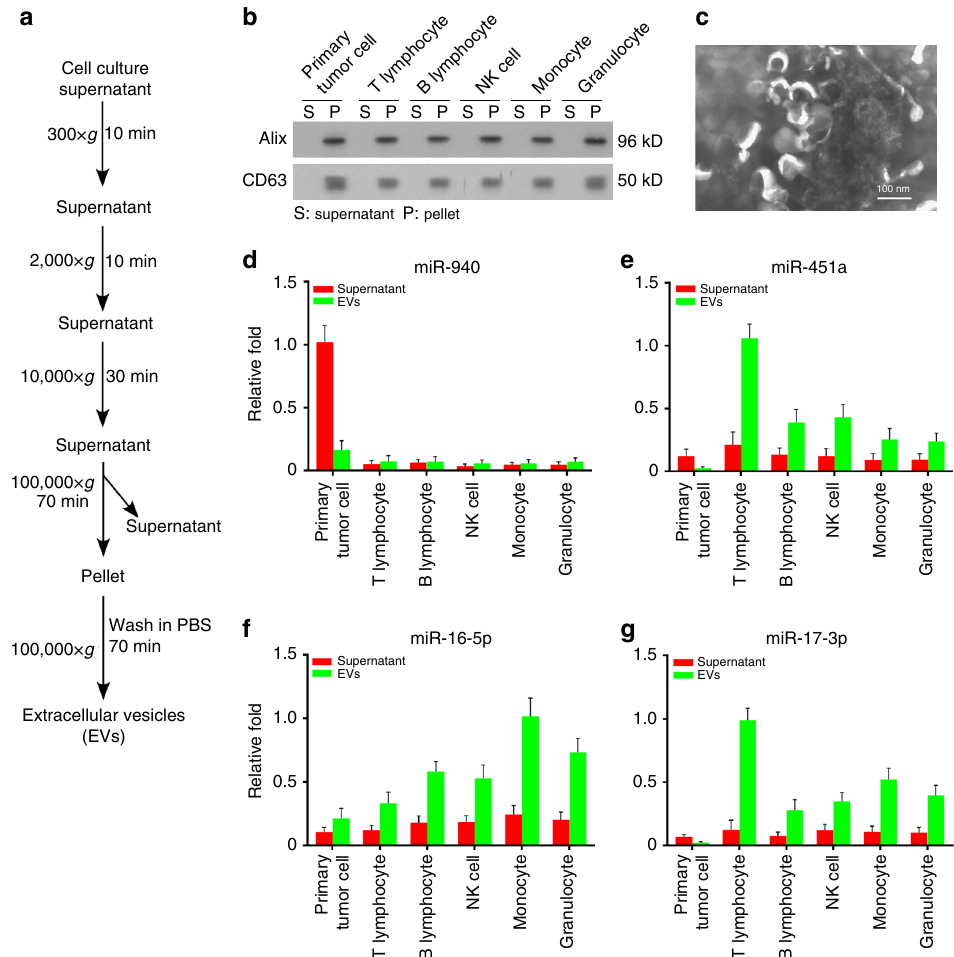
Fig. 6 Origin of the biomarkers. a Strategy for the isolation of EVs and EV-free supernatants from culture supernatants based on differential ultracentrifugation. b Western blot analysis of CD63 and Alix in EVs prepared from pellets or supernatants. c Electron microscopy of puri fi ed EVs. Scale bar, 100 nm. d – g The relative expression levels of miRNAs in EVs and EV-free supernatants of cultured primary tumor cells, T lymphocytes, B lymphocytes, NK cells, monocytes, and granulocytes isolated from 5 patients (mean +